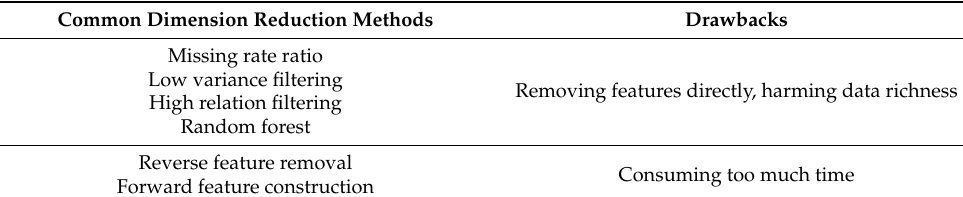
Table 4. Comparison of common feature extraction methods.